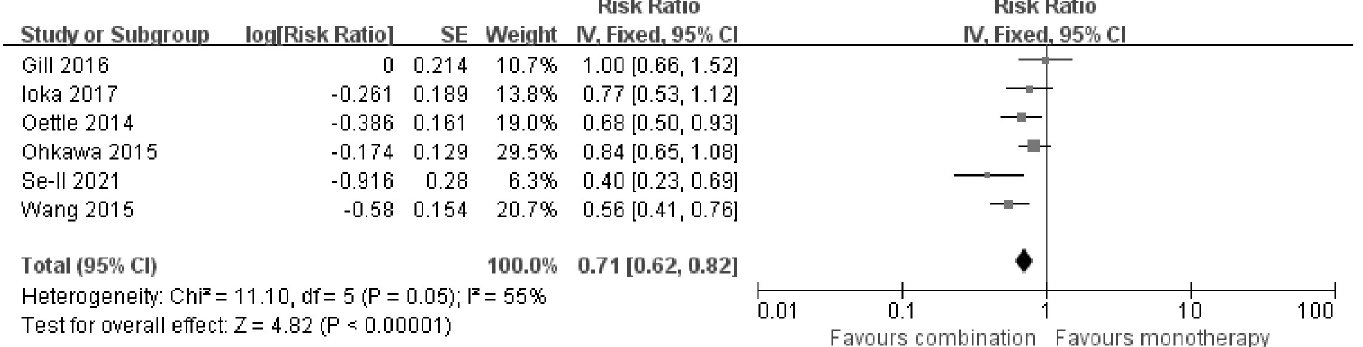
PLOS ONE | https://doi.org/10.1371/journal.pone.0282360 March 2,